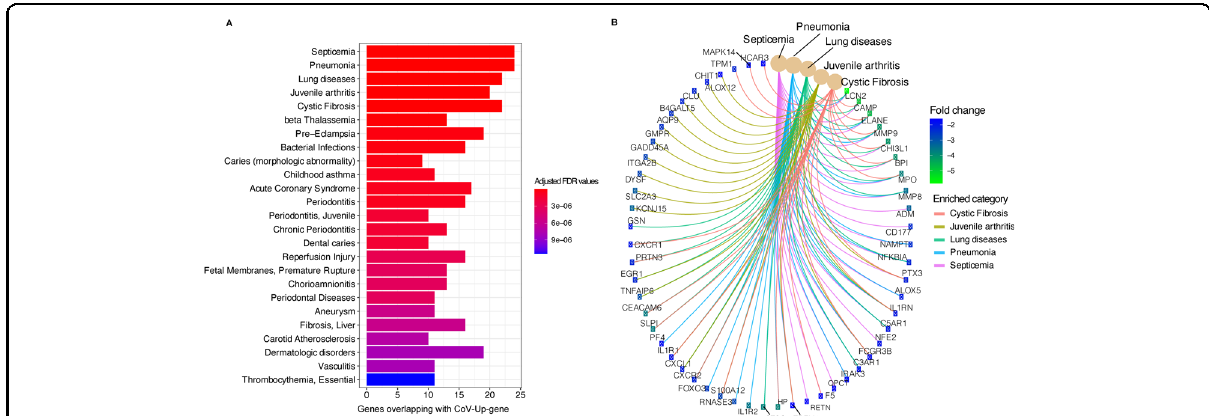
Fig. 7 PBMC-based gene signature identi fi es links to known and novel diseases and disease conditions in coronavirus-infected patients. A , B Enrichment analysis (hypergeometric test using hypeR 57 ) of disease-based gene sets from DisGeNET 62 ( A ). Top fi ve diseases and associated PBMC genes ( B